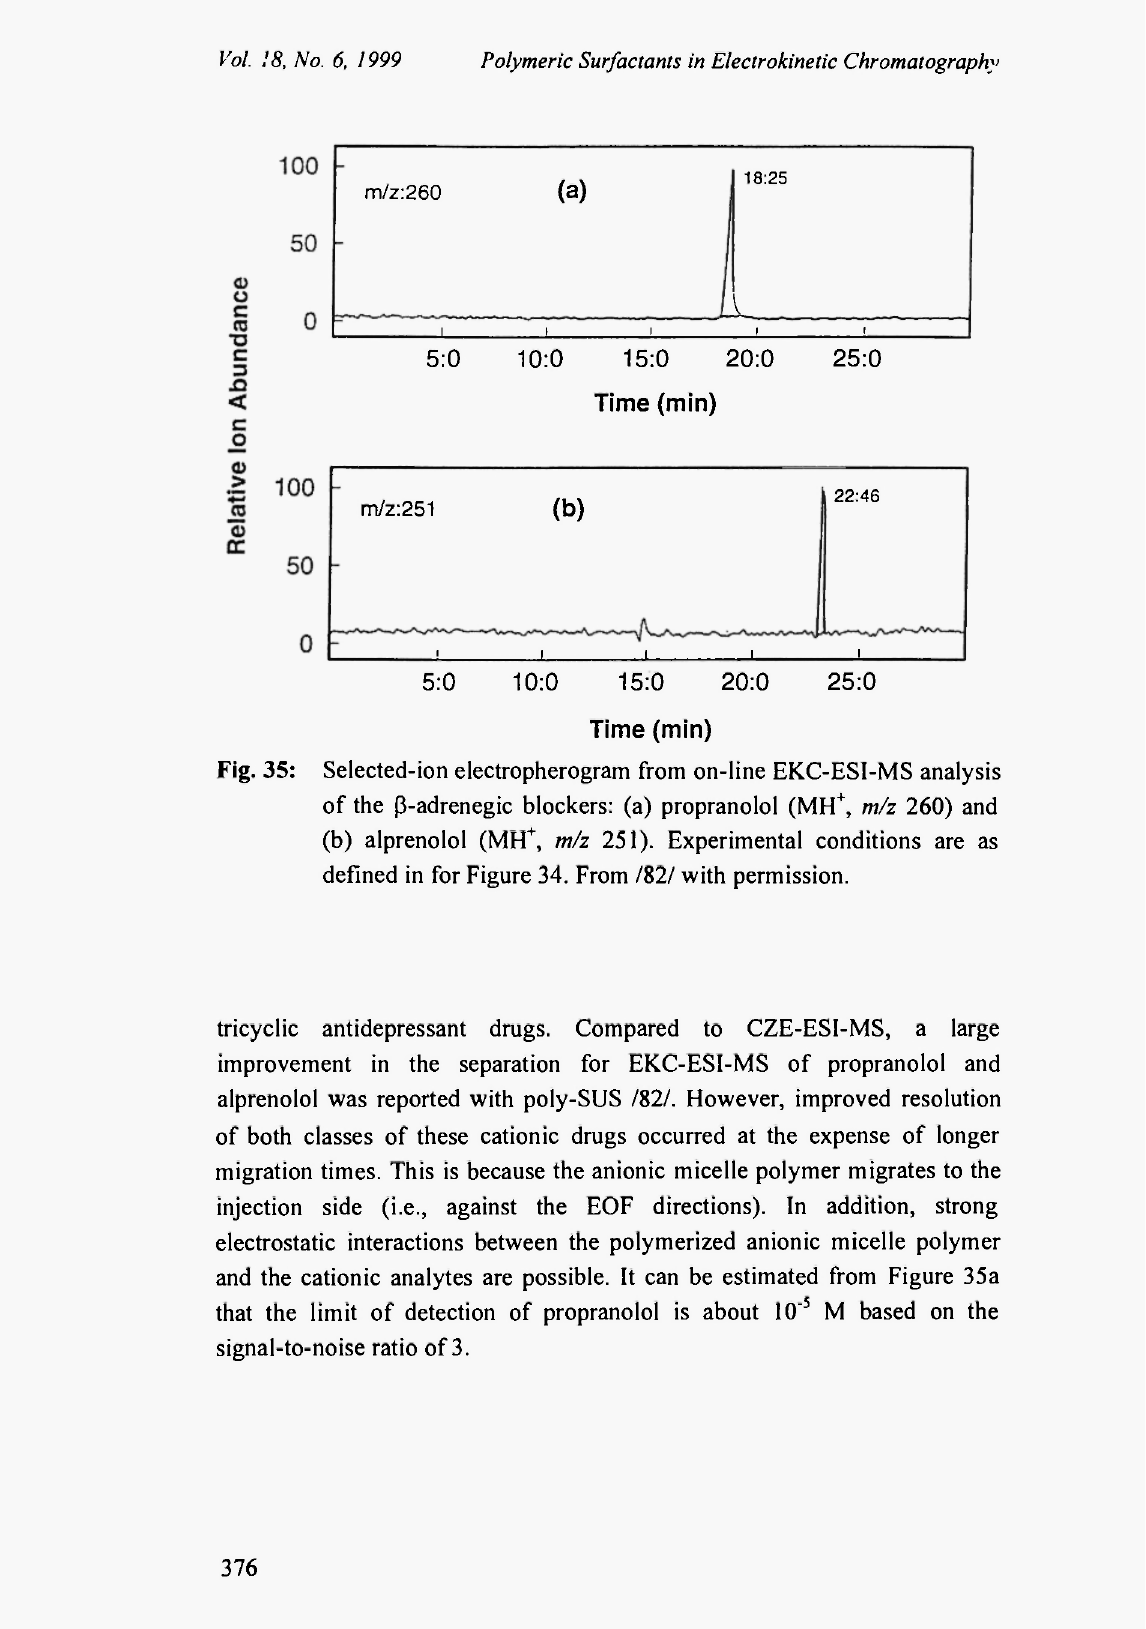
Fig. 35: Selected-ion electropherogram from on-line EKC-ESI-MS analysis of the ß-adrenegic blockers: (a) propranolol (MH + , m/z 260) and (b) alprenolol (MH + , m/z 251). Experimental conditions are as defined in for Figure 34. From /82/ with